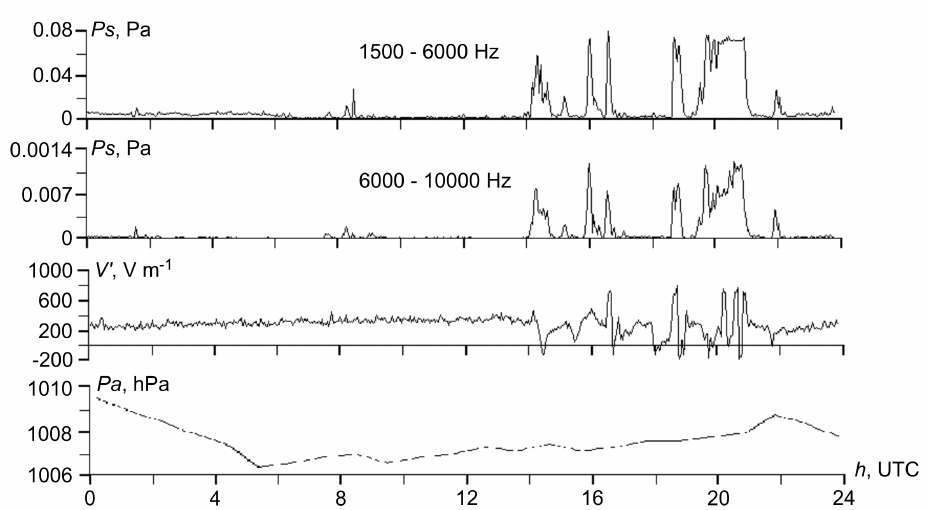
Figure 2. Example of a joint anomalous disturbances of acoustic pressure P s in kilohertz frequency range, atmospheric electric field potential gradient V (cid:48) and atmospheric pressure P a during a seismically calm period on 2 September 2005.